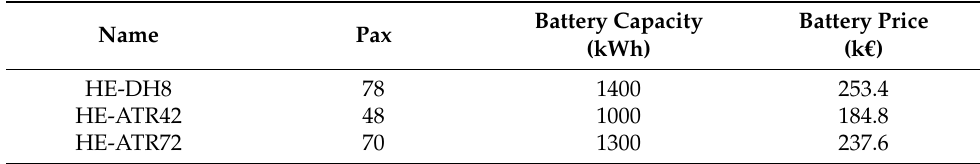
Table 9. Aircraft battery characteristics for LGAV